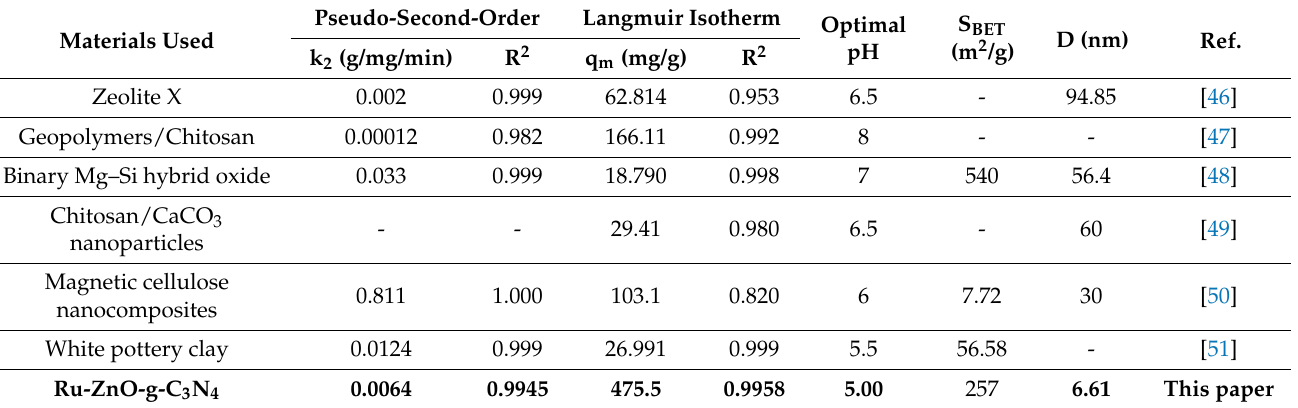
Table 3. Monitoring characteristics for the adsorption of Cd ions onto the Ru-ZnO-g-C 3 N 4 nanocom- posites in comparison to other adsorbents and nanostructures.